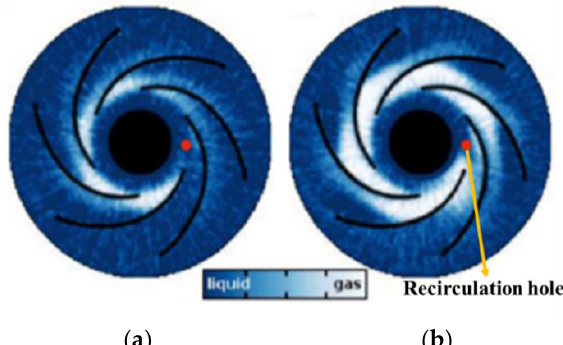
Figure 10. Unequal distribution of gas in the impeller running at 1480 rpm, produced by the recir- culation hole [57], ( a ) λ = 1% and ( b ) λ = 2 . 6%. recirculation hole [57], ( a ) λ = 1% and ( b ) λ = 2.6%.